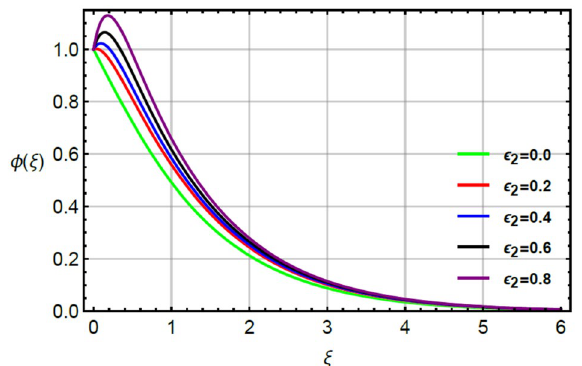
Figure 14. Character of ǫ 2 on φ .